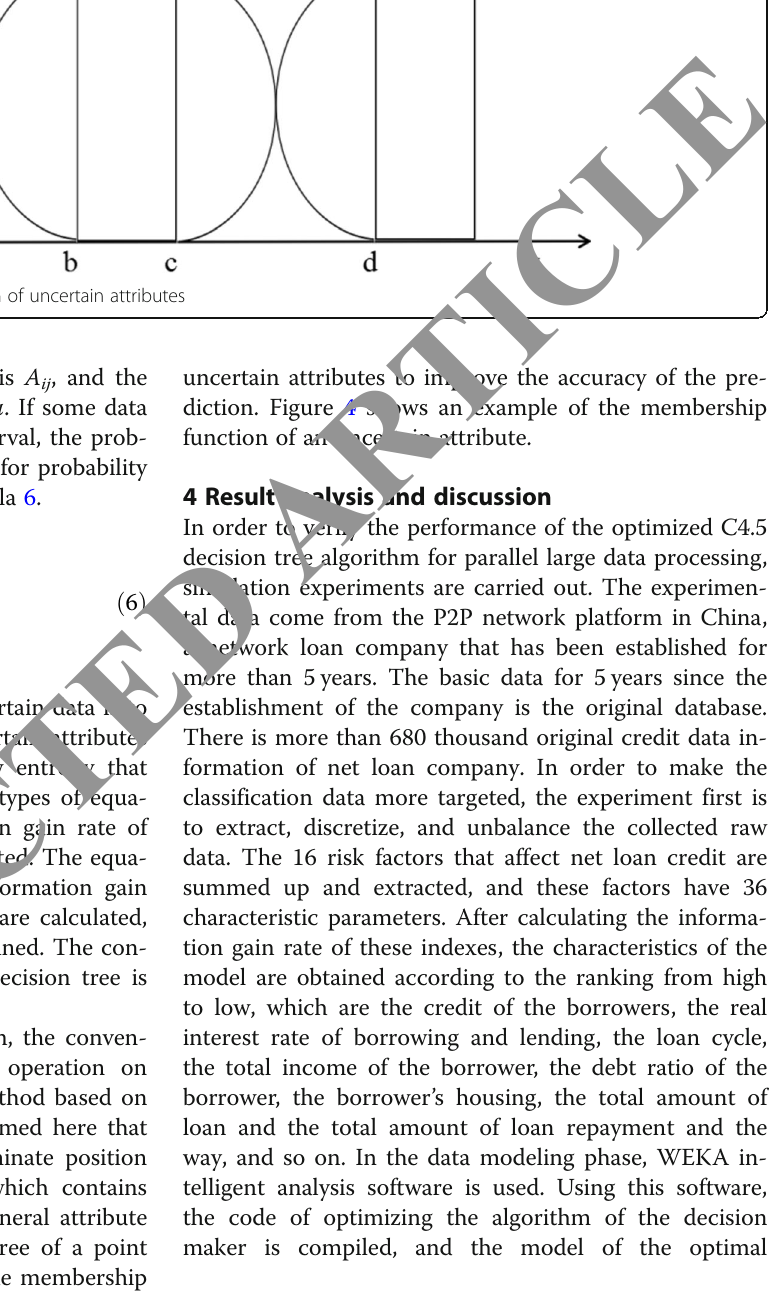
Table 2 Model data results of the P2P net loan platform